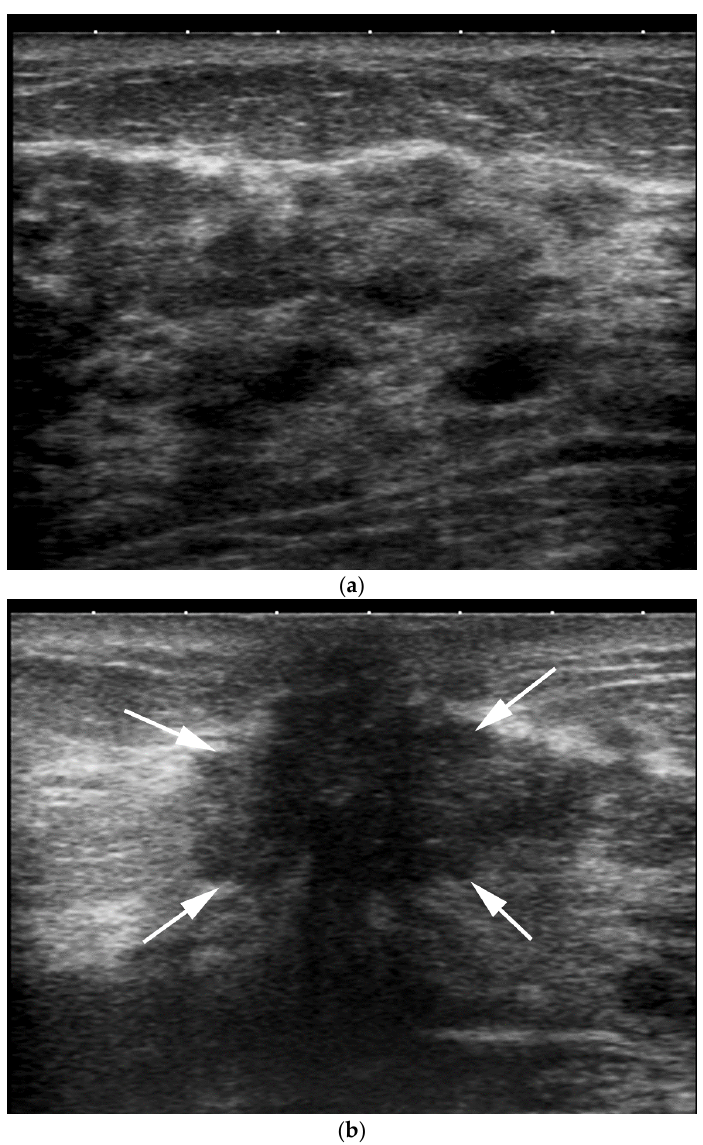
Figure 9. Comparison with the contralateral side can help the breast imager. US transverse images of the right ( a ) and left ( b ) retroareolar area. Right retroareolar area shows a simple cyst ( a ) versus left retroareolar area ( b ) shows a subtle hypoechoic irregular mass with posterior shadowing (arrows). Pathologic analysis yielded invasive ductal carcinoma.